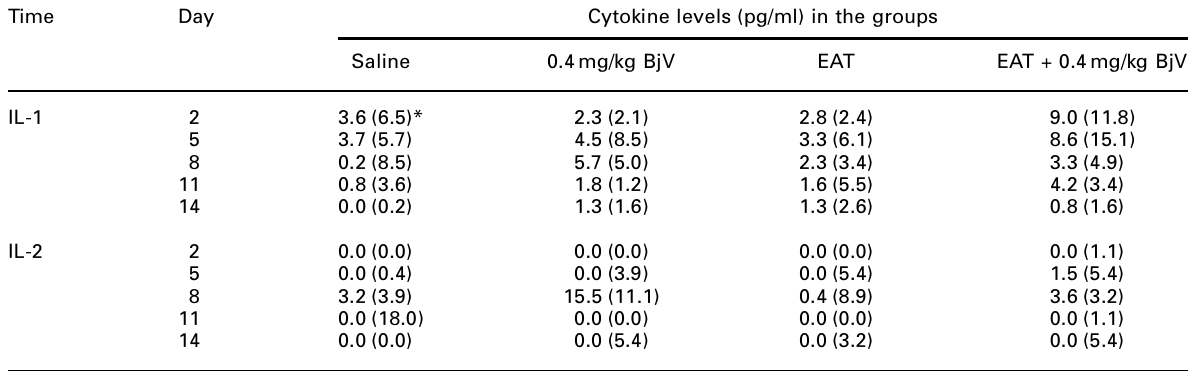
Table 1. Cytokine levels in the experimental groups inoculated with EAT cells and/or 0.4mg/kg of Bj V after 2, 5, 8, 11, and 14 days of tumor growth Time Day Cytokine levels (pg/ml) in the groups Saline